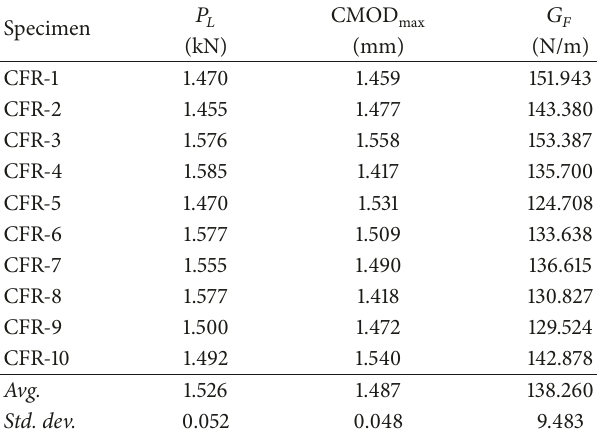
Figure 8: Fracture energy for CCR.